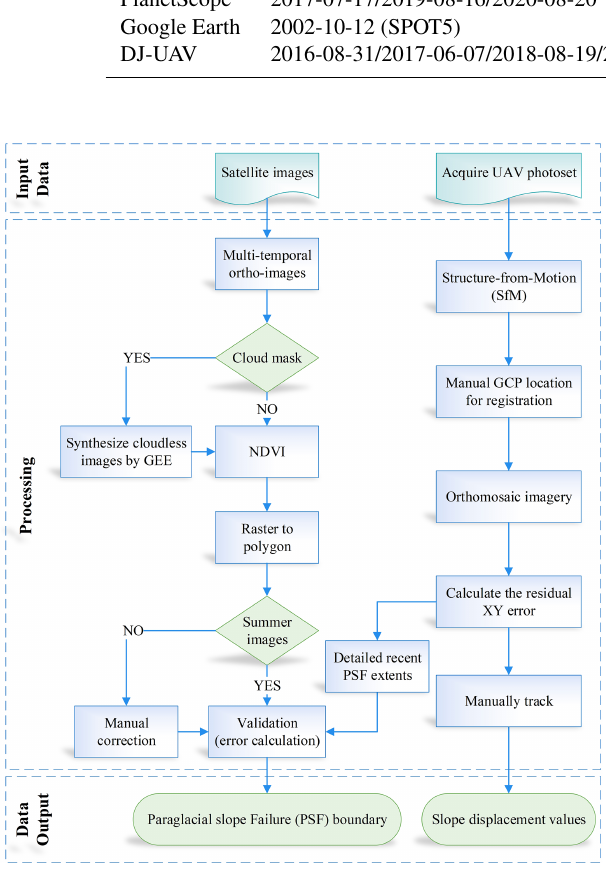
Figure 2. Workflow for mapping the PSFs (changes) and tracking the displacement from multi-temporal image